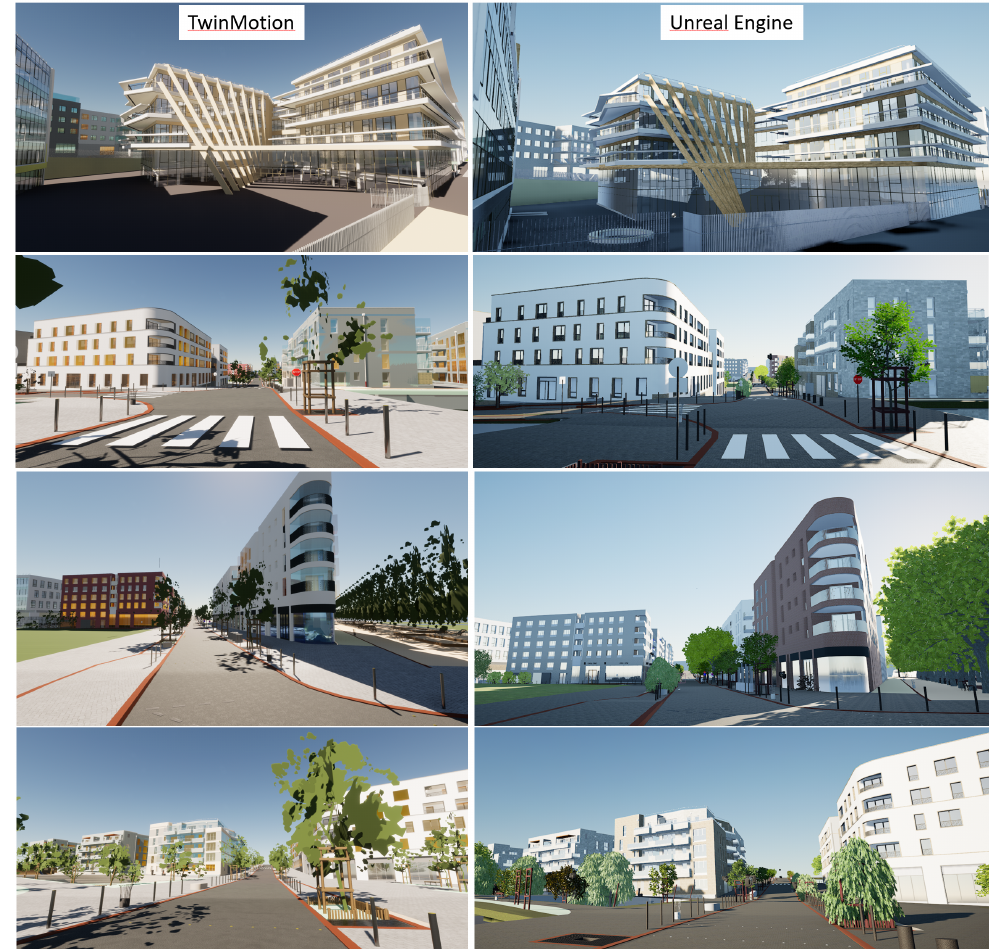
Figure 19. Left: TwinMotion project. Right: Unreal Engine scene. The Unreal Engine texture and lighting conform more to reality than the TwinMotion scene, which is more cartoonish.